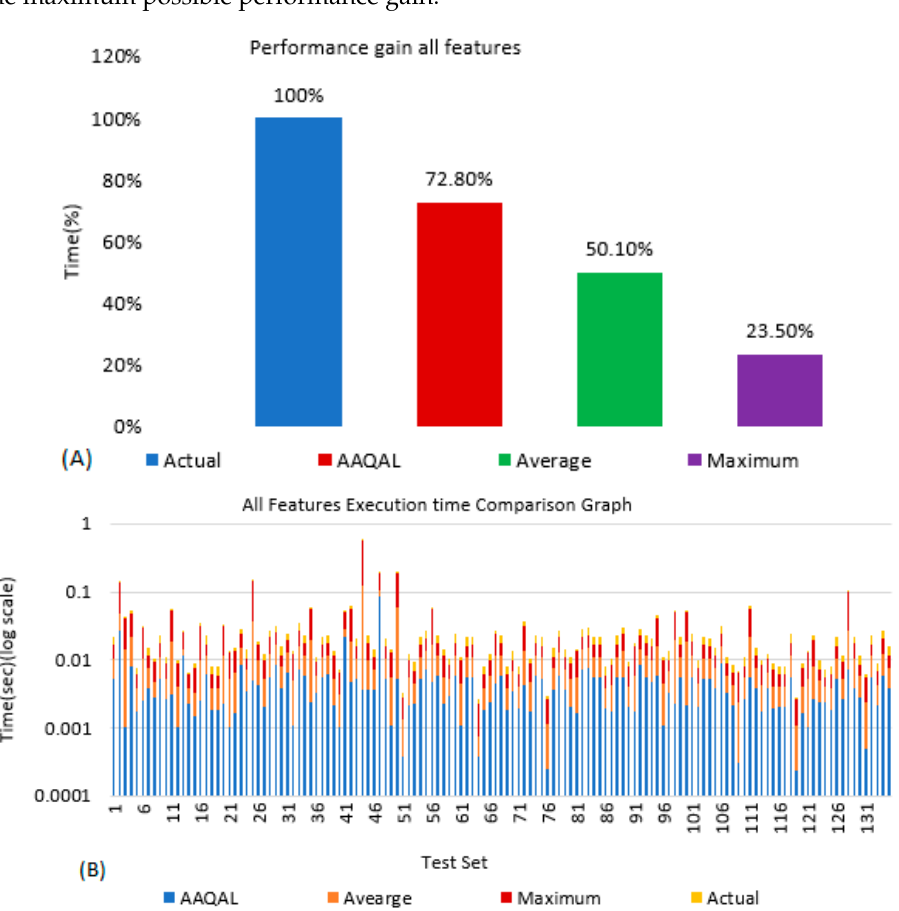
Figure 15. Performance gain ( A ) and execution time comparison ( B ) with all features (Test